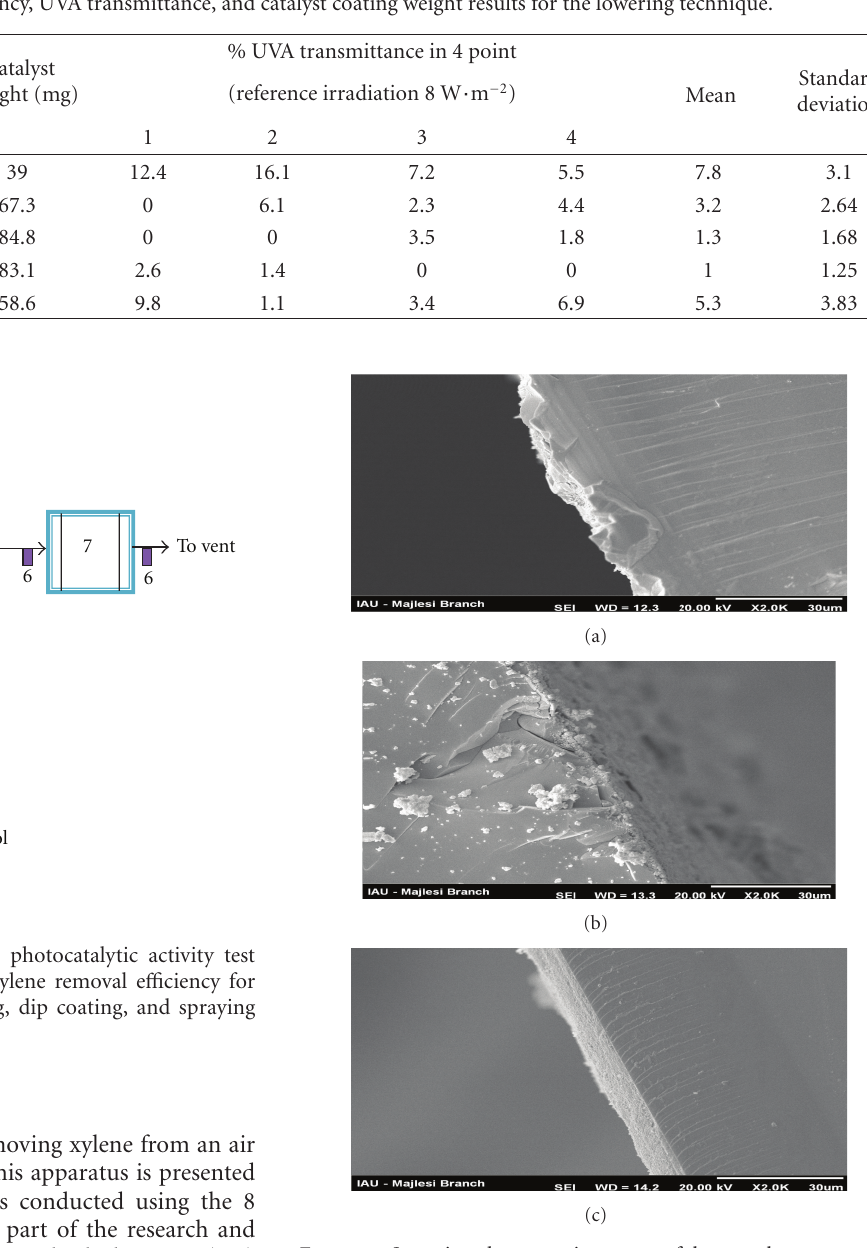
Figure 5: Scanning electron microscopy of the samples prepared by the lowering (a), dip coating (b), and spraying techniques